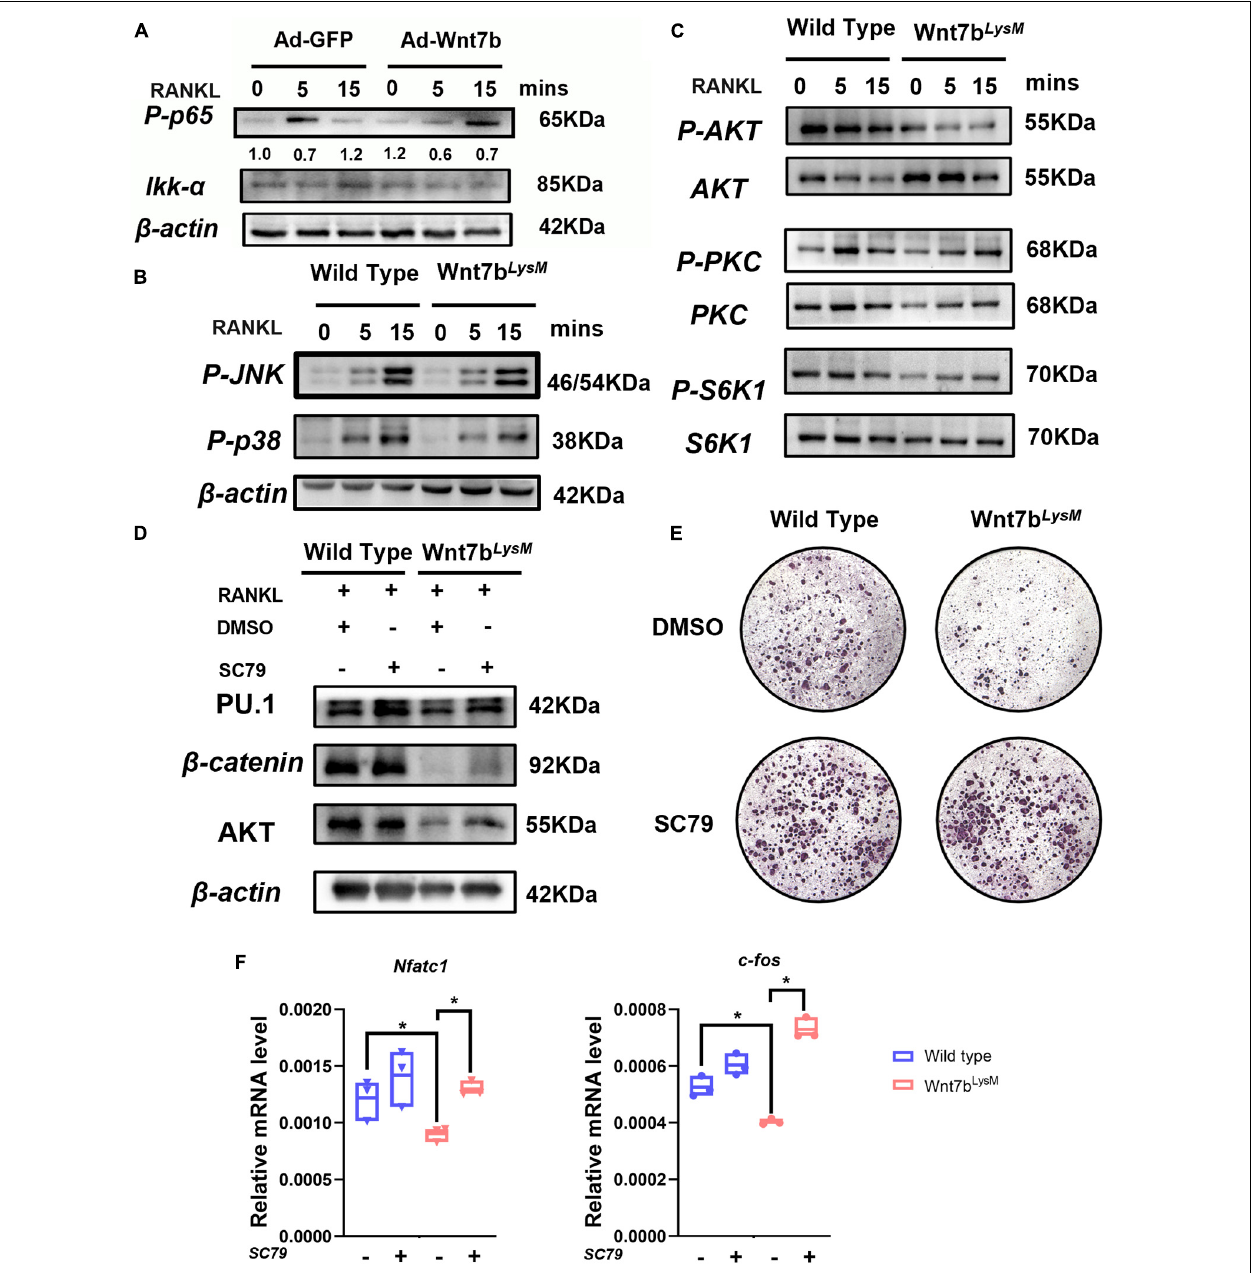
FIGURE 4 | Wnt7b inhibited osteoclast differentiation by suppressing AKT phosphorylation. (A) Raw264.7 cell line transfected with adeno-GFP as control or adeno-Wnt7b was treated with RANKL for the indicated periods. Cell lysates were subjected to Western blot (WB) analysis for canonical NF- κ B signal pathway. The relative densities of blots are shown on top of IKK-a. (B,C) BMMs isolated from WT or Wnt7b LysM mice were stimulated with RANKL for increasing time. Whole-cell lysates were collected for Western blotting analysis of targets of MAPK pathway (p-p38 and p-JNK) and targets of mTOR pathway (p-AKT, AKT, p-PKC, PKC, p-S6K1, and S6K1). (D) BMMs obtained from WT or Wnt7b LysM mice were incubated with RANKL for 1 day together with vehicle (DMSO) or SC79 addition. The expression levels of early osteoclast differentiation proteins in BMMs were analyzed by WB. (E) Osteoclastogenesis were determined with RANKL for 5 days with SC79 or DMSO. TRAP staining was performed to identify the TRAP-positive multinucleated cells. (F) The expression levels of early osteoclast differentiation markers in BMMs were analyzed by quantitative PCR after treated with SC79 or DMSO. N = 3. * p <